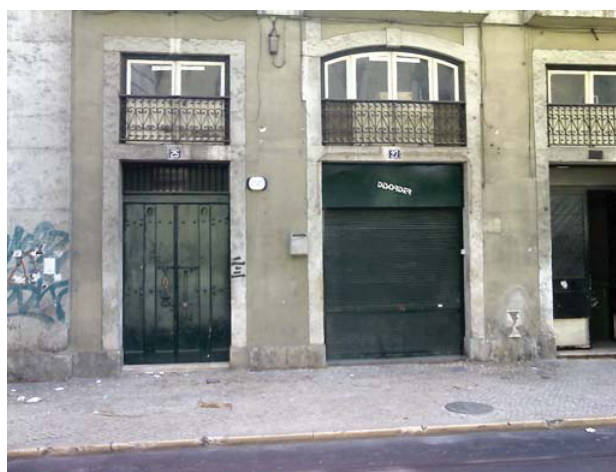
Figure 3. View of a vacant